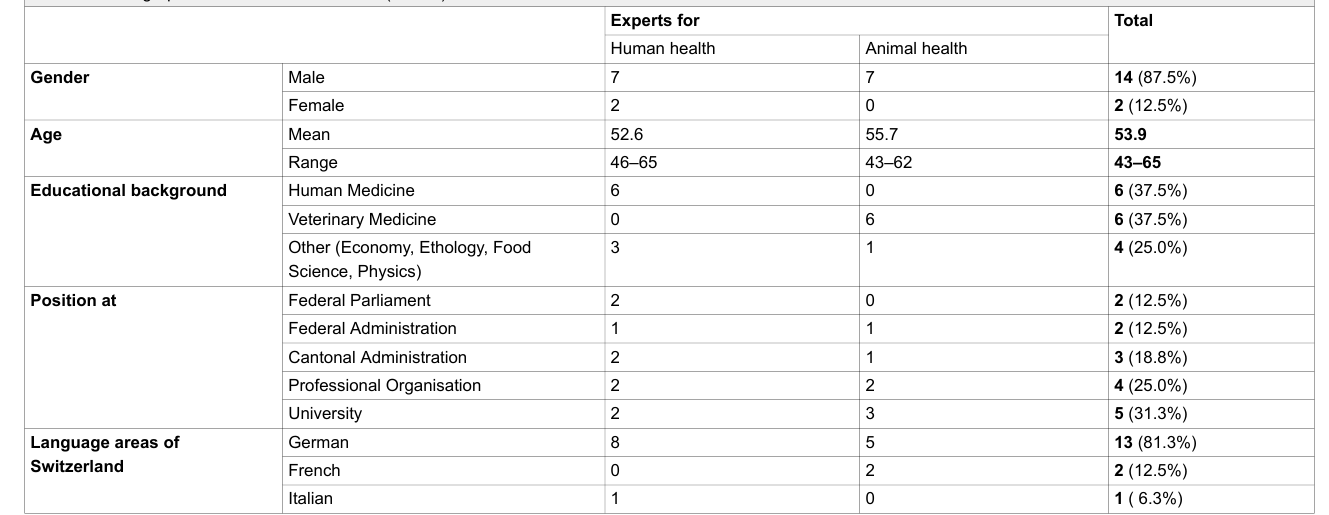
Table 1: Demographic data of the interviewees (N =